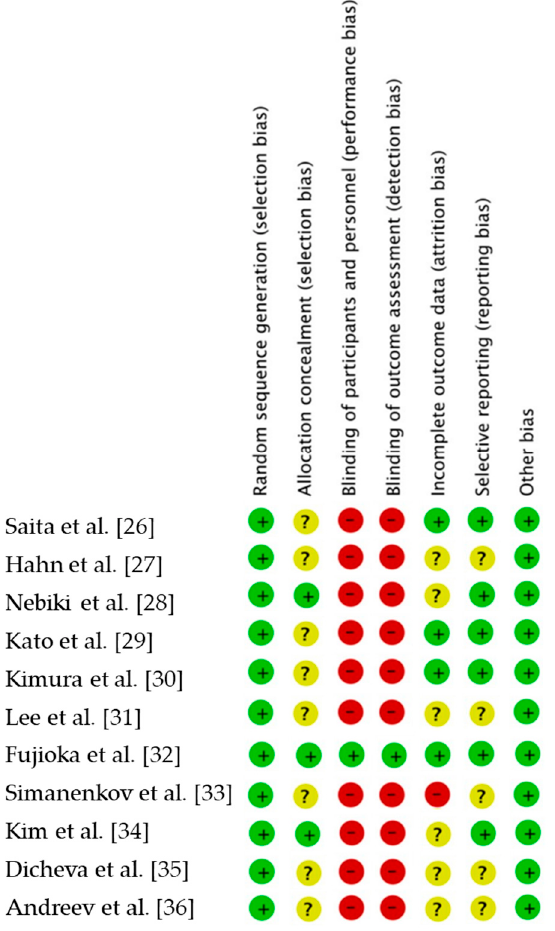
Figure 2. Risk of bias. Green, low risk of bias; yellow, unclear risk of bias; red, high risk of bias.